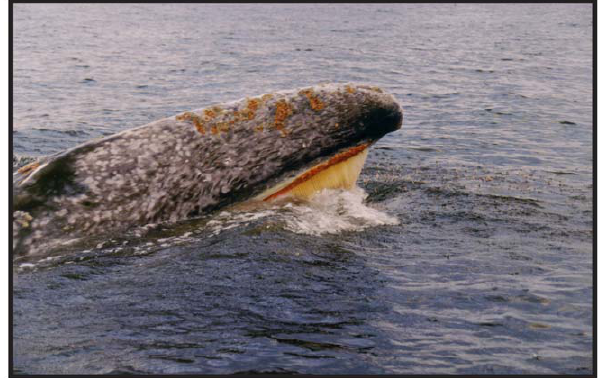
Figure 5. Non-migratory gray whale feeding. Photograph of a gray whale feeding on herring near Cape Scott, Vancouver